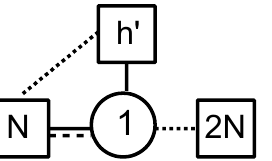
Figure 13 . ADHM SQM associated with the L 1 ; 1 bubbling. h 0 = N + 1 for N even and h 0 = N for N